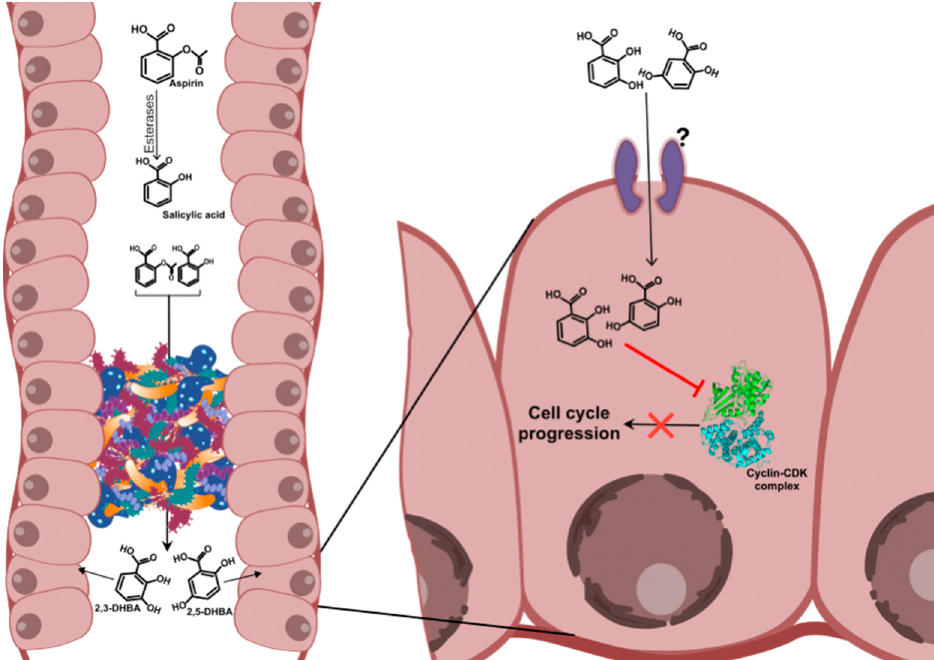
Figure 2. Metabolite hypothesis. According to this hypothesis, the unabsorbed aspirin and salicylic acid in the intestine and colon are biotransformed by the colonic microbiota to generate metabolites such as 2-3-dihydroxybenzoic acid (2,3-DHBA) and 2,5-DHBA. These HBAs are taken up by the colonic epithelial cells and may arrest cell growth by inhibiting cyclin dependent kinases (CDKs) and/or other proteins. It is suggested that a reduced rate of cell proliferation would provide the cells with an opportunity to repair damaged DNA, enhancing genetic stability. Alternatively, it would also provide cells of the immune system time to recognize tumor cells through immune surveillance and destroy them [44].